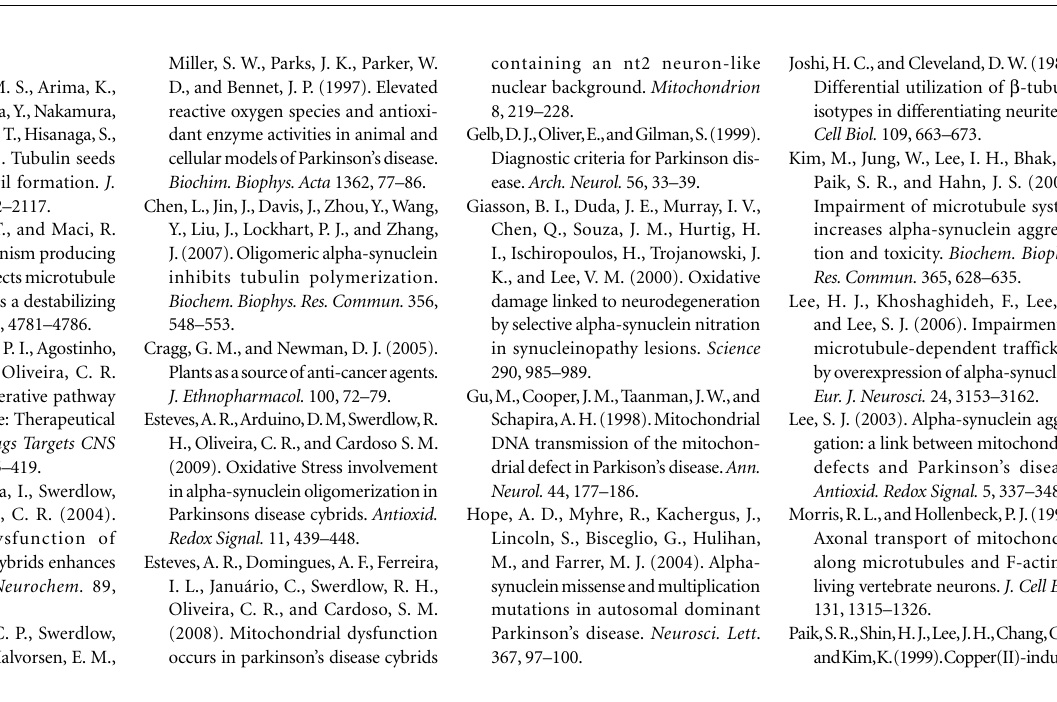
** P < 0.01, signifi cantly different when compared to the untreated CT cybrid cells. # P < 0.05 and ## P < 0.01, signifi cantly different as compared to the untreated PD cybrid